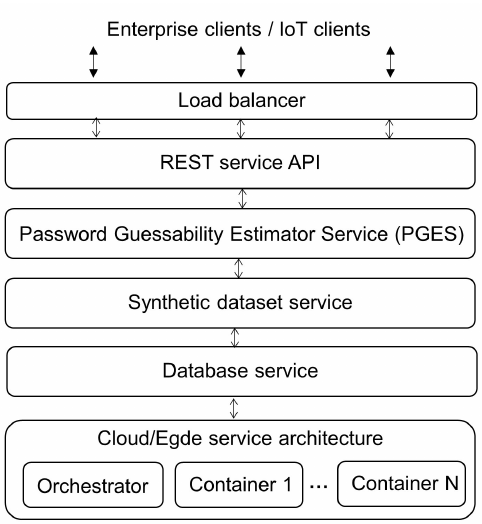
Figure 1. Proposed